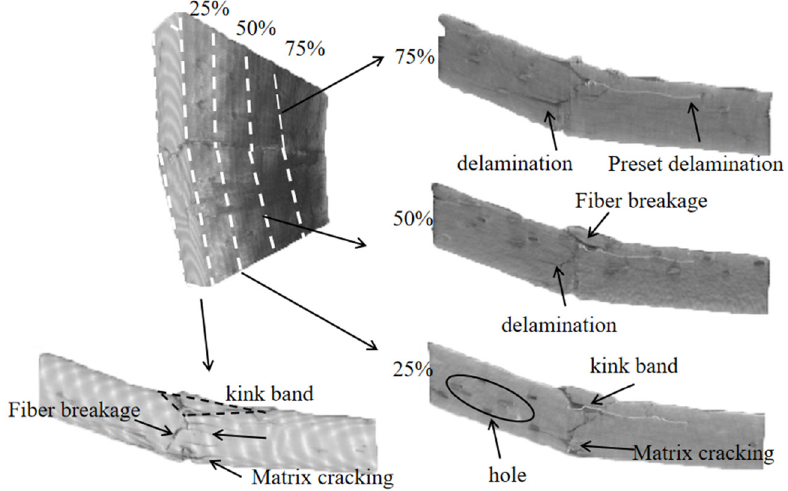
Figure 11: Micro - CT images of failure modes of specimen A at 25, 50, and 75% cross sections in the width